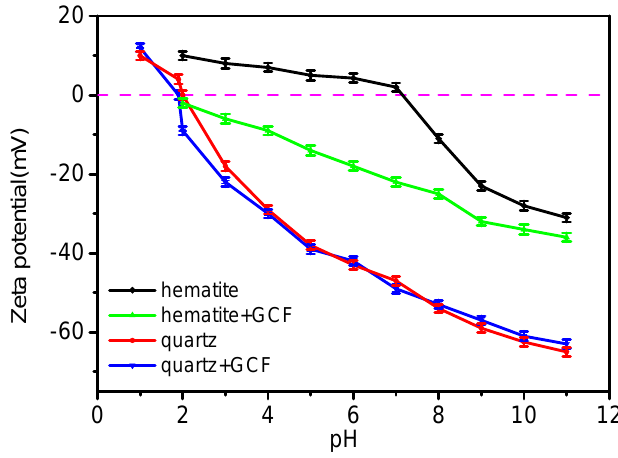
Figure 10. Effect of GCF on the Zeta potential of hematite and quartz at different pH.